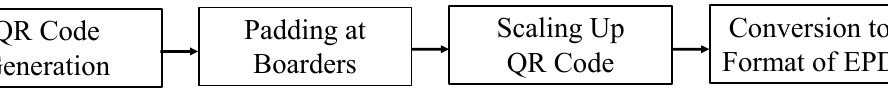
Figure 3. Functional block diagram of power management circuit.